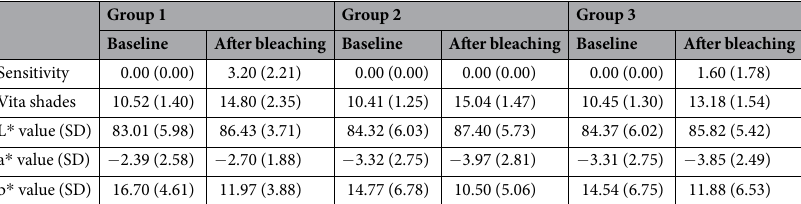
Table 1. Distribution of VAS tooth sensitivity scores and L * a * b * shade values [means ± standard deviations (SD)] before and after bleaching of teeth. Group 1 = Teeth bleached with ozone then 38% hydrogen peroxide (n = 90 tooth surfaces in 15 participants). Group 2 = Teeth bleached with 38% hydrogen peroxide then ozone (n = 90 tooth surfaces in 15 participants). Group 3 (control) = Teeth bleached with 38% hydrogen peroxide only (n = 90 tooth surfaces in 15